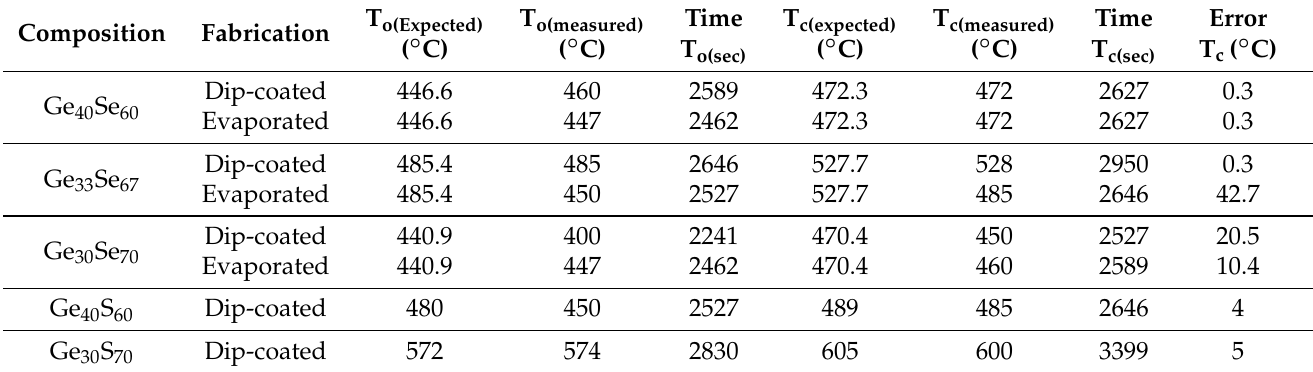
Table 3. Temperature response of Ge-S and Ge-Se tip-coated optical fiber-based temperature sensor. Composition